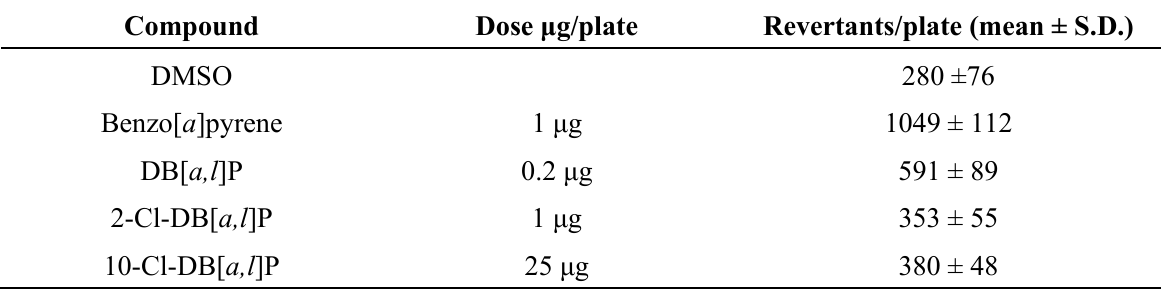
Table 1. Mutagenicity of DB[ a,l ]P, 2-Cl-DB[ a,l ]P, and 10-Cl-DB[ a,l ]P in Salmonella typhimurium TA100 in the presence of S9 enzyme